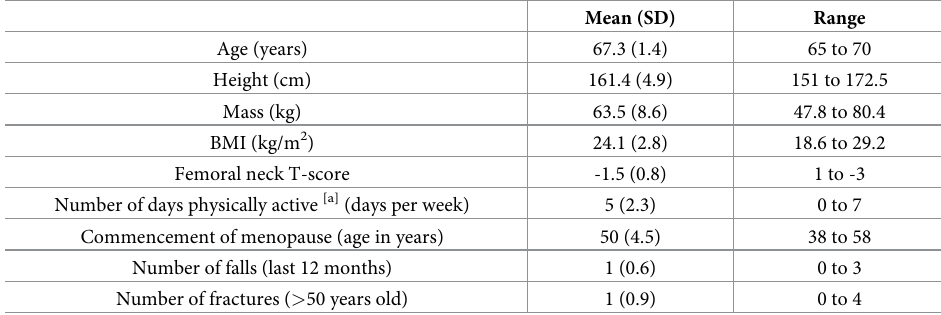
Table 1. Participant (n = 45)